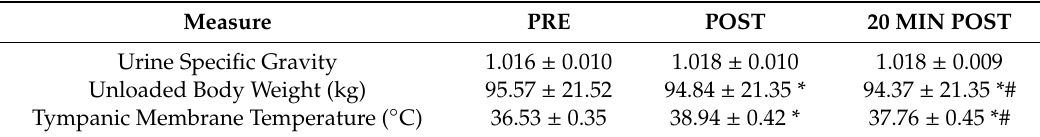
Table 2. Mean data ± SD and ranges for the pre-scenario and post-scenario